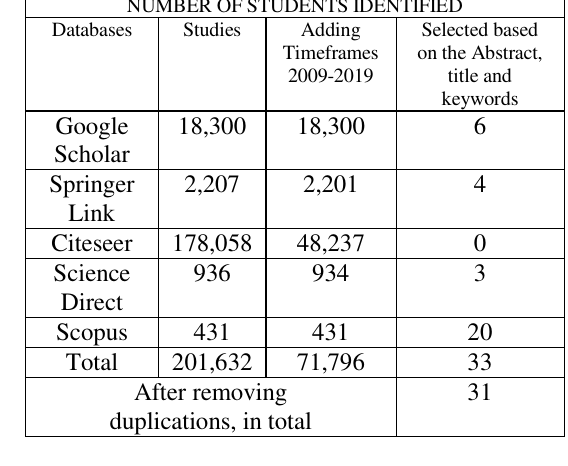
TABLE 2: CATEGORIES USED IN EXTRACTING AND ANALYZING